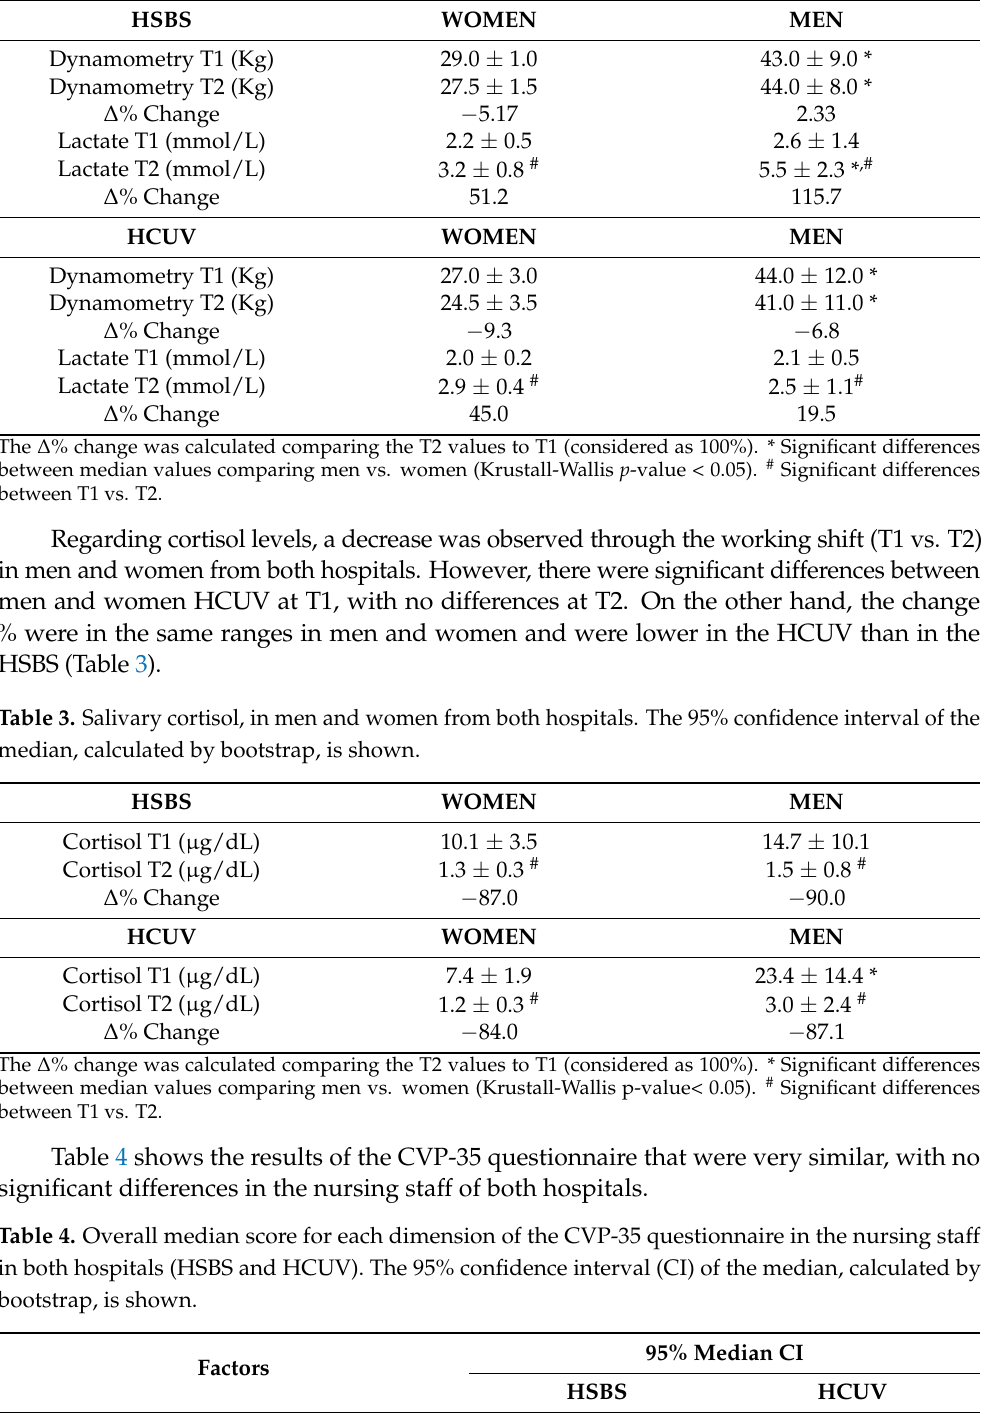
Table 2. Dynamometry values and post-test blood lactate levels in nurses (men and women) from both hospitals. The 95% confidence interval of the median, calculated by bootstrap, is shown.